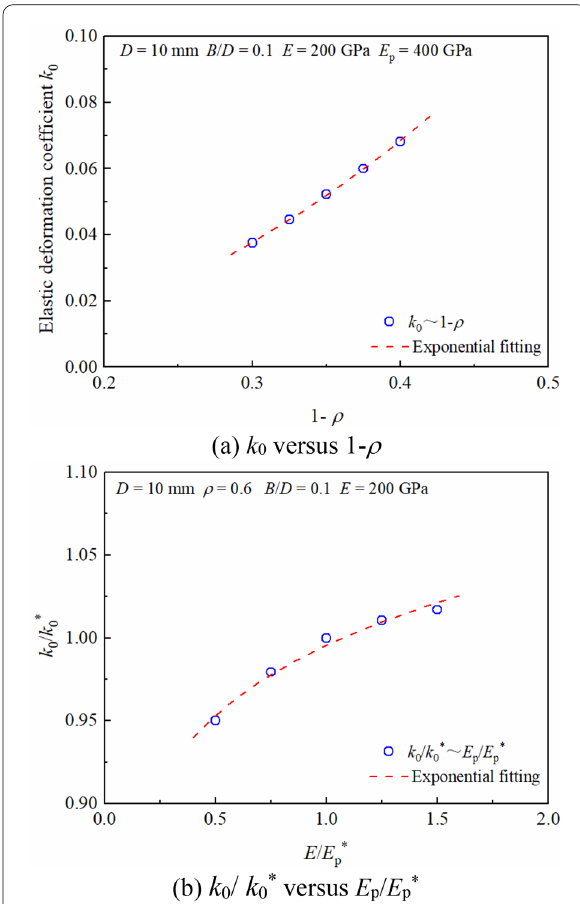
Figure 6 Fitting relations between ( E p , ρ ) and k 0